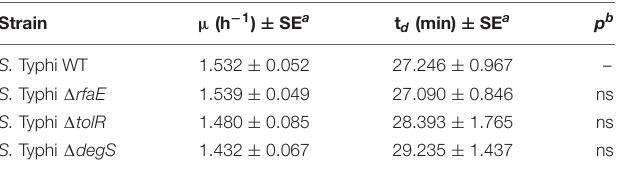
Strains were cultured in LB at 37 ◦ C with shaking. Bacterial growth was assessed by measuring OD 600 over time. a n = 4 (with 8 technical replicates). SE, standard error. b One-way ANOVA, with Tukey as post hoc test. ns = non-significative compared with S. Typhi